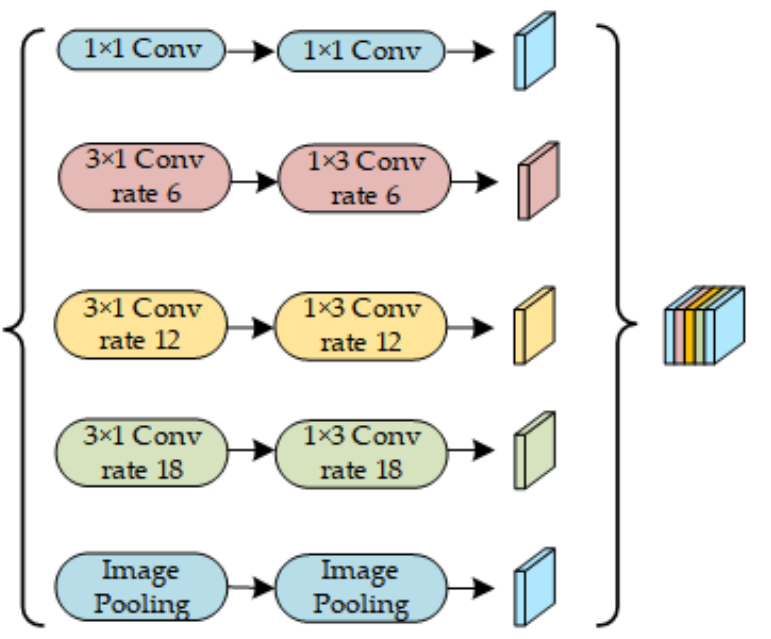
Figure 5. Schematic diagram of improved ASPP model.